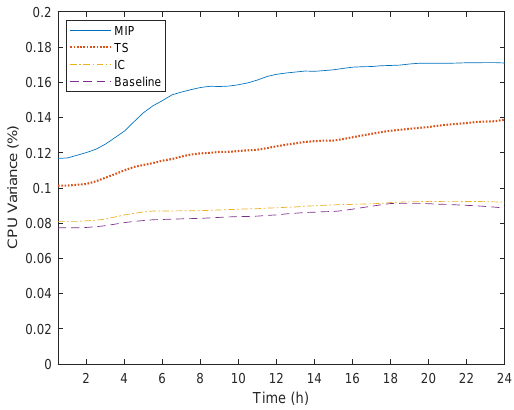
Figure 14. Average CPU variance of activated